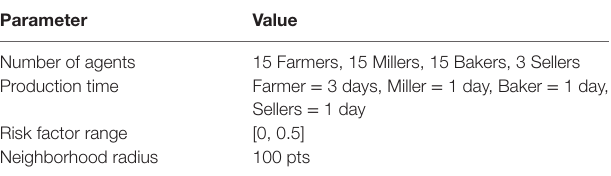
TaBle 5 | initial conditions for experiment #3, case B.